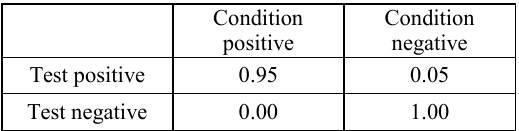
Table 5. Positive predictive value of the 19 Hz C-SVM linear test.